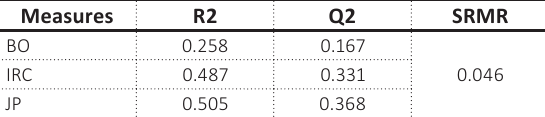
Table 4. R2, Q2, and SRMR